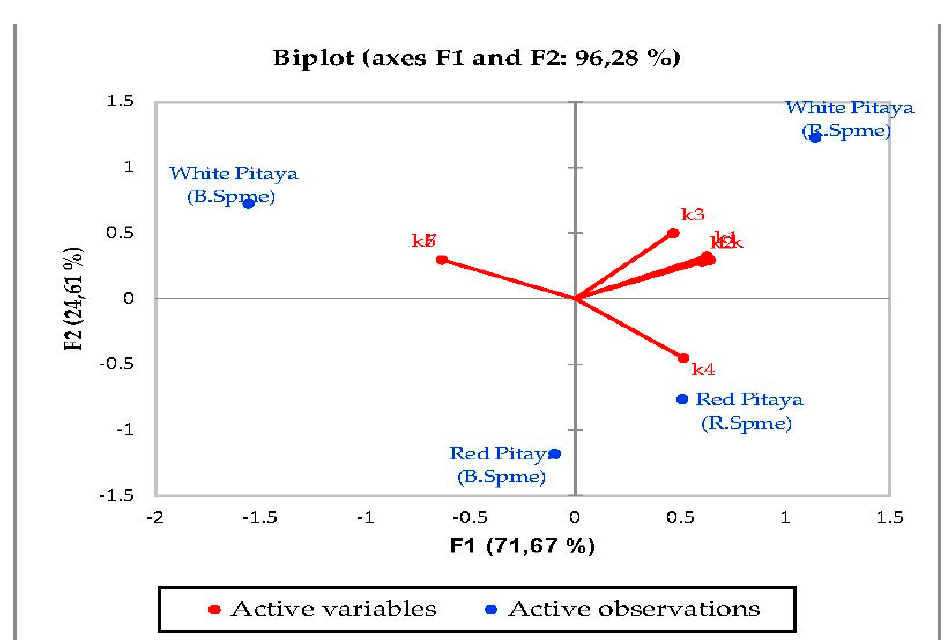
Figure 4. Biplot graph (scores and loading plots) obtained from Principal Component Analysis for ketones from volatile compounds in red-white pitaya. k1: 1-hydroxy- 2-Propanone,k2: 1-(2-furanyl)- Ethanone, k3: 2,3-Butanedione, k4: 2-Propanone, k5: 5-hexyldihydro- 2(3H)-Furanone, k6: diphenyl- Methanone, k7: <delta->Dodecalactone; R.Spme: Red Spme; B.Spme: Blue Spme.